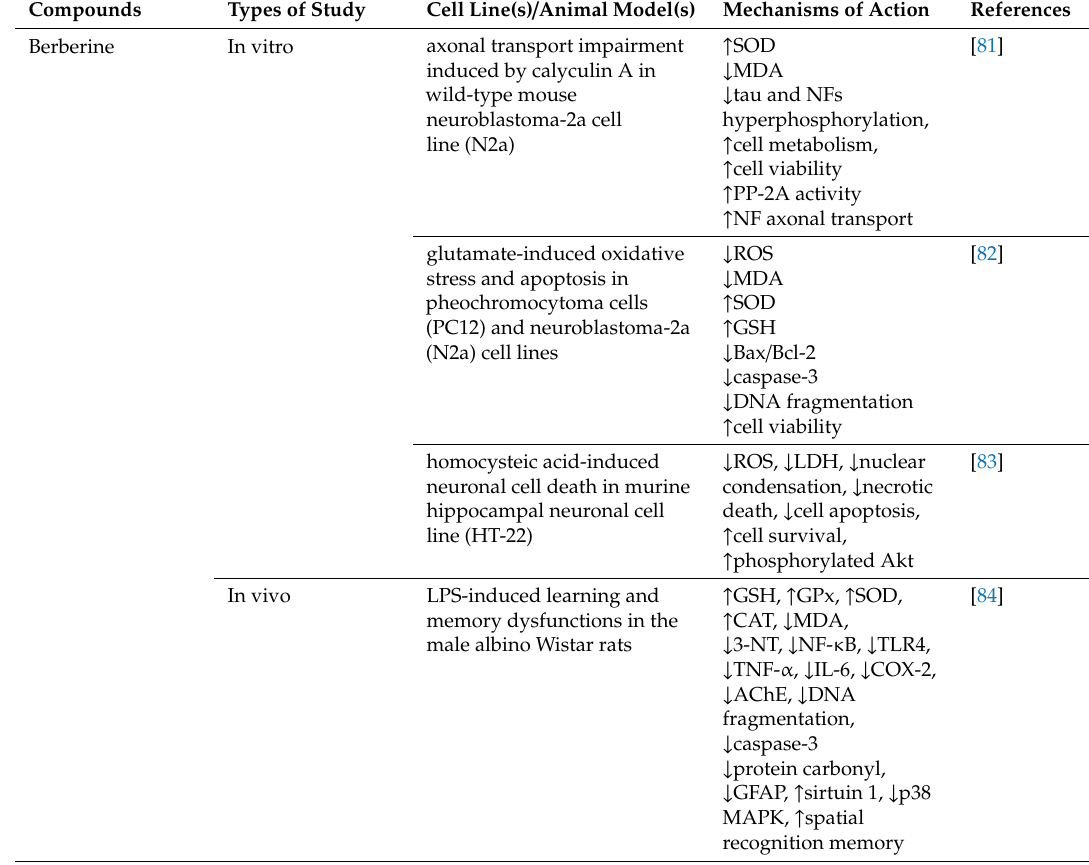
Table 2. Alkaloids in combating AD through Nrf2 / Keap1 / ARE and interconnected pathways.